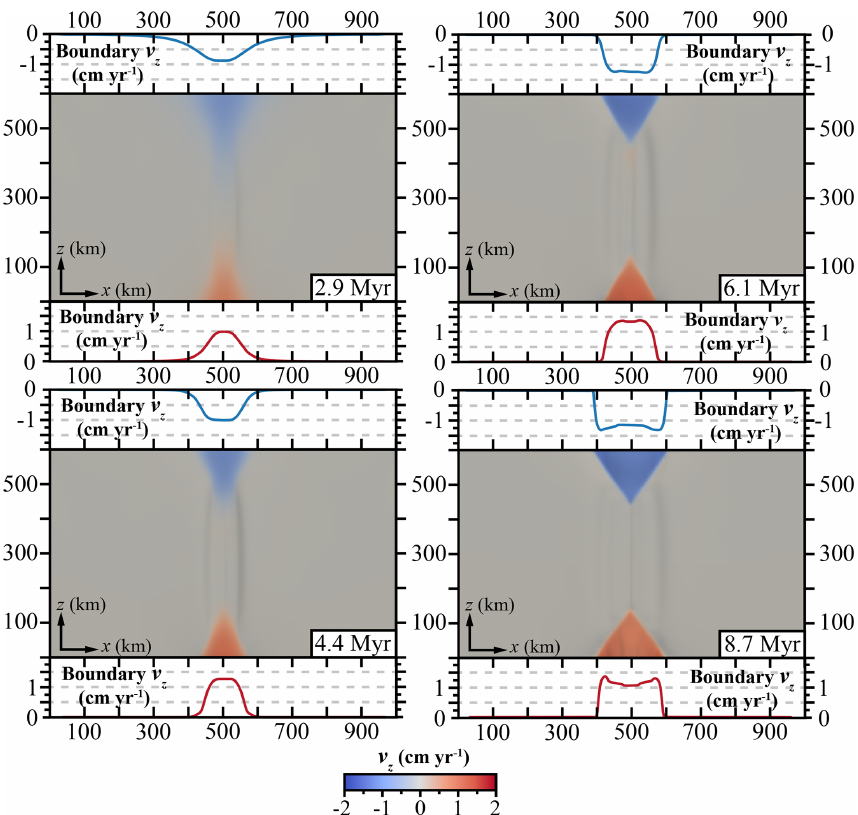
Figure 13. Map view of the z component of the velocity ( v z ). Red curves represent the z component of the velocity along the boundary z max at the surface. Blue curves represent the z component of the velocity along the boundary z min at the